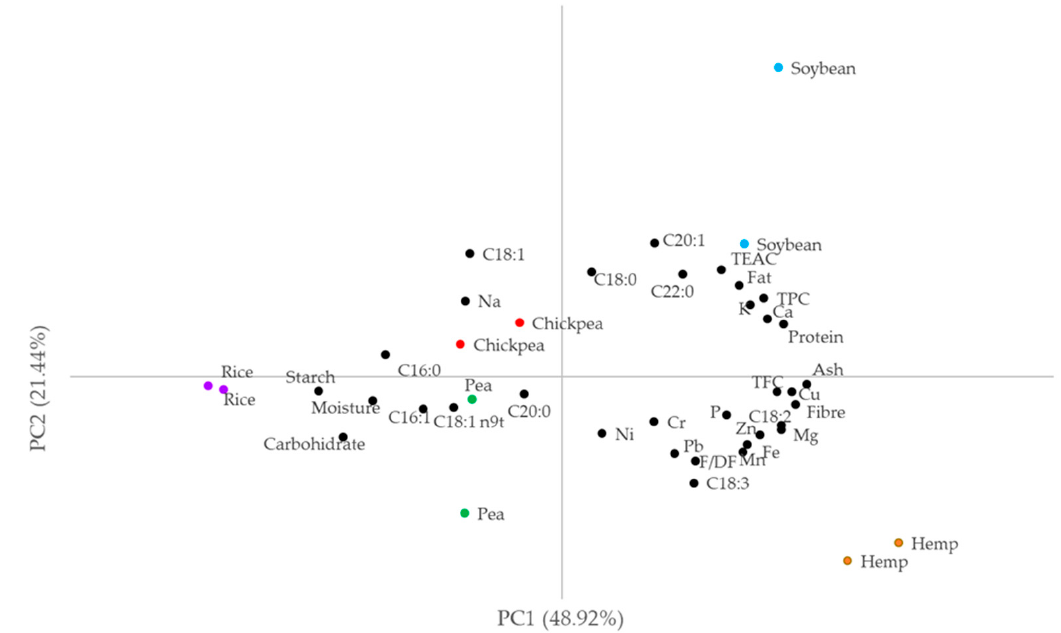
Figure 1. Projection plot of the flour samples in the space defined by the two firsts PCs. TPC: total phenolic content, TFC: total flavonoid content, F/DF: flavanones and dihydroflavonols, TEAC: total equivalent antioxidant activity (nmol Trolox/100 g).